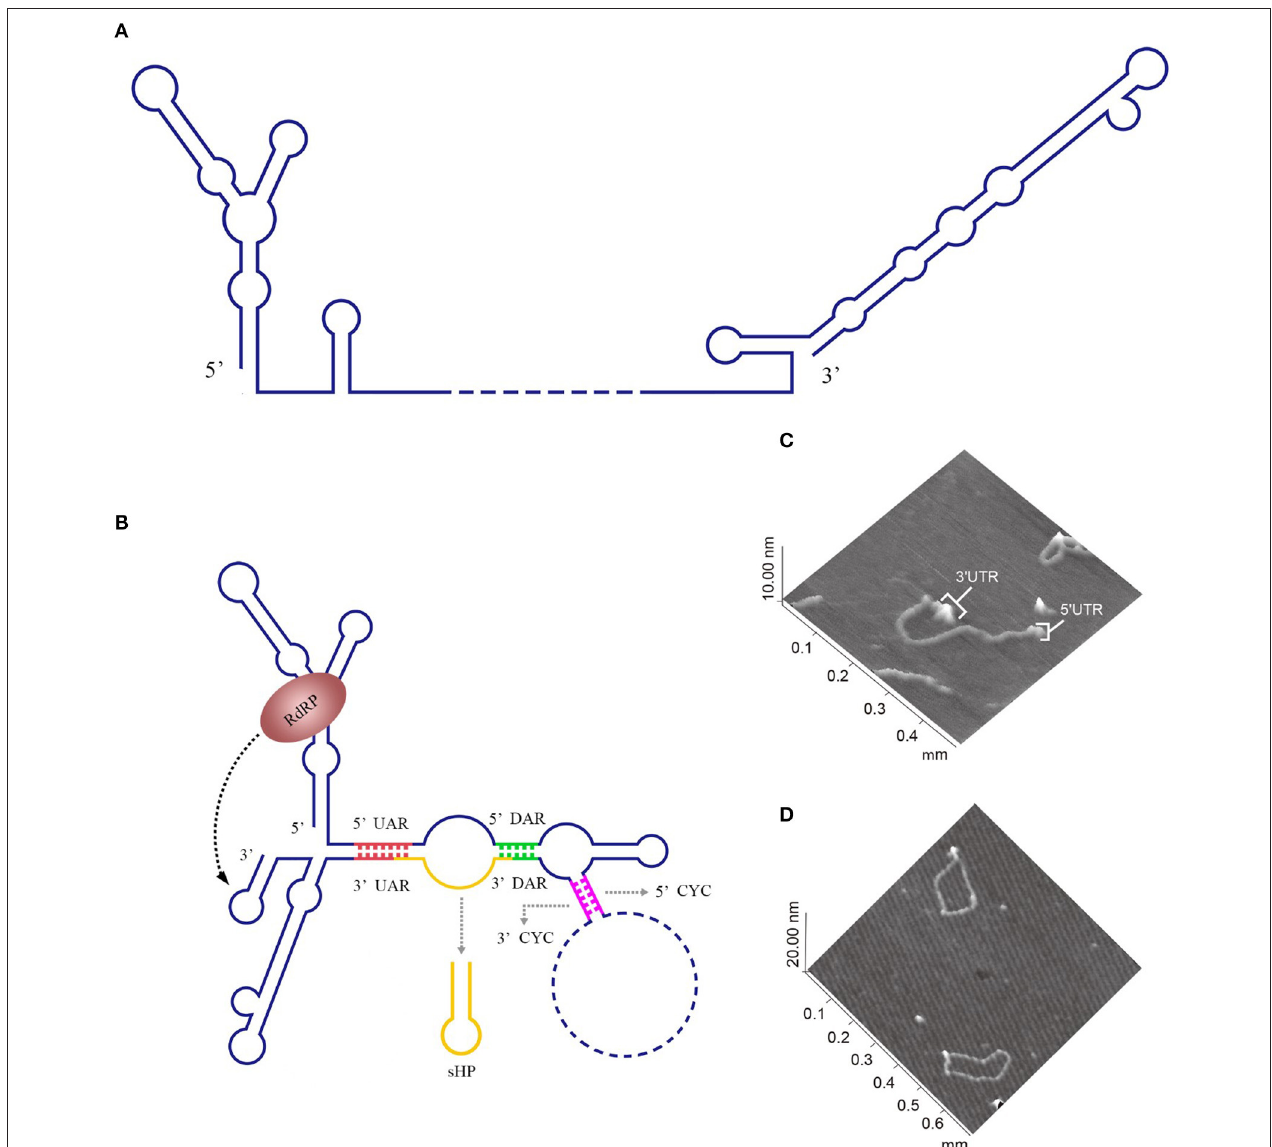
FIGURE 2 | Circularization of the DENV genome. (A) The linear form of the DENV genomic RNA. When the interactions between the 3 ′ and 5 ′ cyclization sequences are not considered, the DENV genome appears in a linear form (Villordo and Gamarnik, 2009). (B) The circularized form of the DENV genomic RNA. 5 ′ CYC/3 ′ CYC, 5 ′ UAR/3 ′ UAR, and 5 ′ DAR/3 ′ DAR bind complementarily and cyclize the DENV genome, reducing the distance between the 5 ′ and 3 ′ ends and exposing the 3 ′ -terminal nucleotides, which are indispensable for RdRP to recognize the 3 ′ -terminus and initiate negative-strand synthesis [reviewed in Nicholson and White (2014)]. (C) Visualization of the model RNA molecules using AFM. A single RNA molecule is shown in a linear conformation. The double-stranded RNA region is flanked by single-stranded regions corresponding to the 5 ′ UTR and 3 ′ UTR of dengue virus. (D) Image of individual RNA molecules in the circular conformation. Contacts between the 5 ′ and 3 ′ single-stranded regions of the molecules are observed. The images shown in (C) and (D) were excerpted from a previous study (Alvarez et al., 2005) after obtaining the authors’ permission. Figures have been approved by the original author and obtained the licenses through Rights Licensing Expert (www.copyright.com), the license numbers were, respectively 4045761041172 (for A,B ) 4040580733464 (for C,D